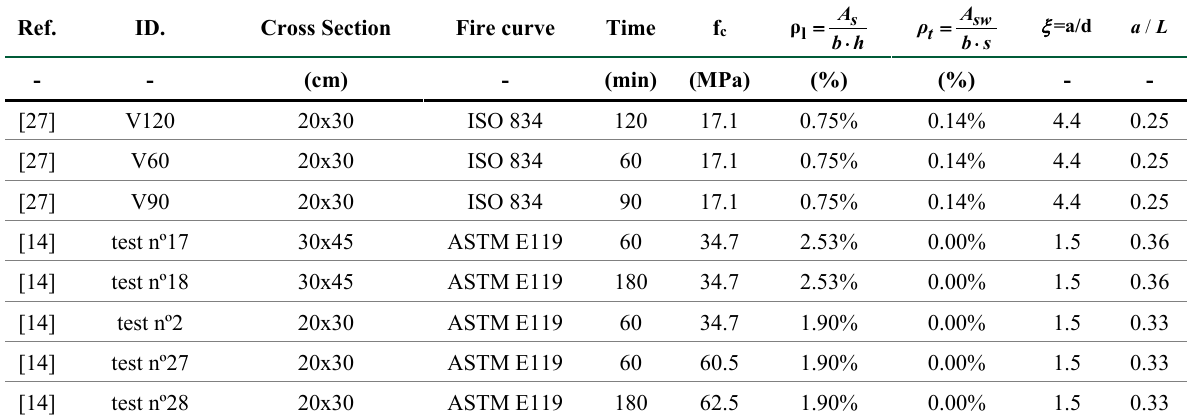
Table 2. Identification and characteristics of the beams analyzed to shear